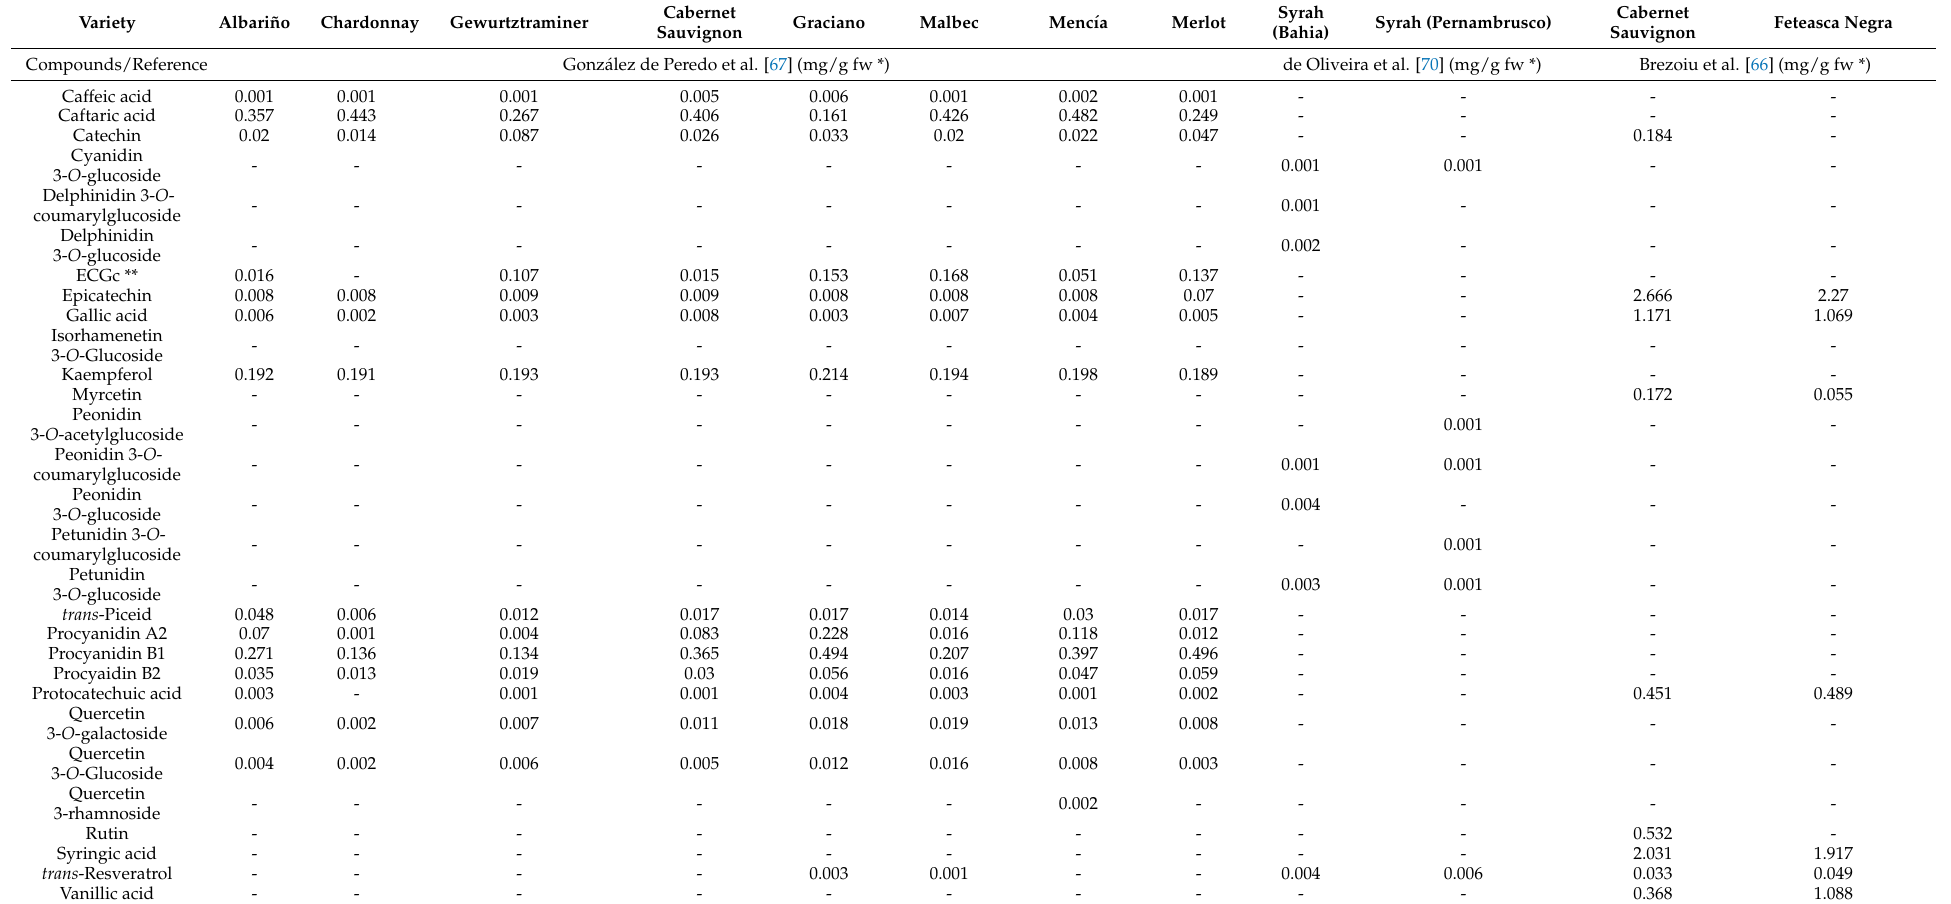
Table 1. Concentration of phenolic compounds (mg/g) quantified in grape varieties analyzed under different conditions. * fw: fresh weight; dw: dry weight; ** ECGc: Epigallocatechin gallate; -: this compound has not been analyzed during this